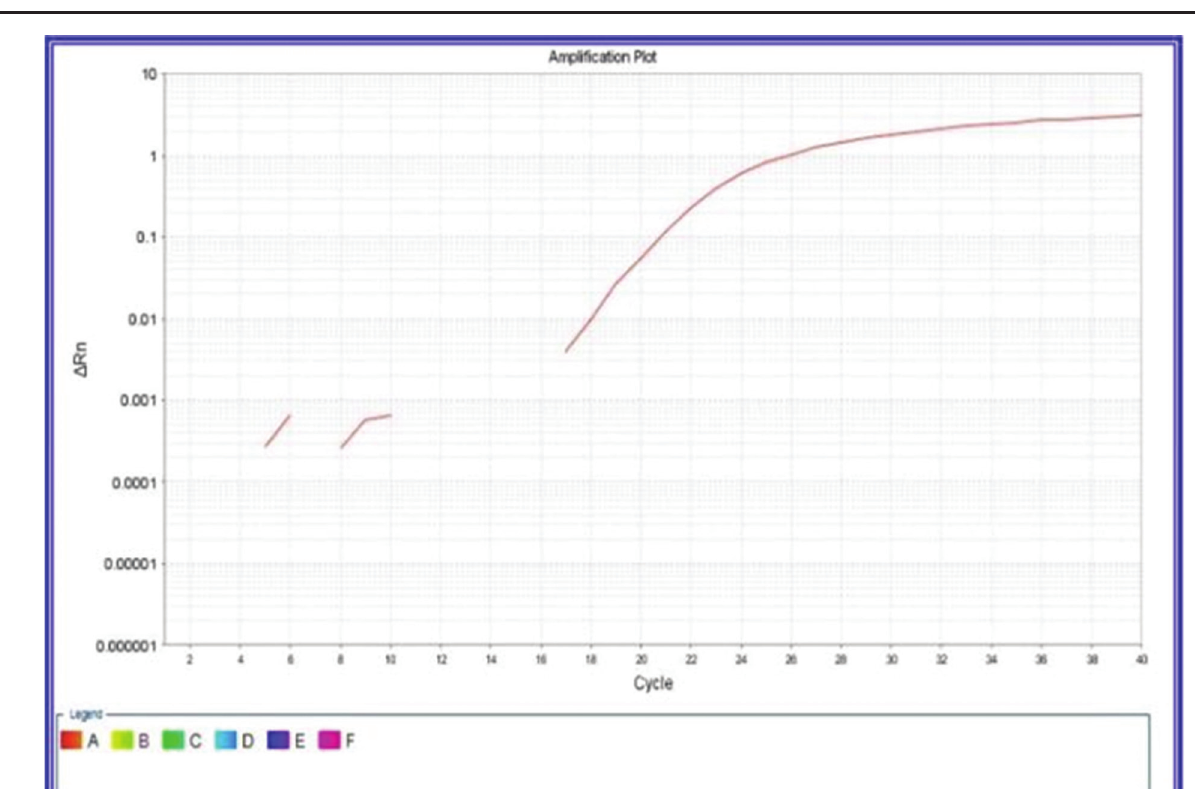
Positive PCR control curve (human DNA to assure the extraction and amplification process).